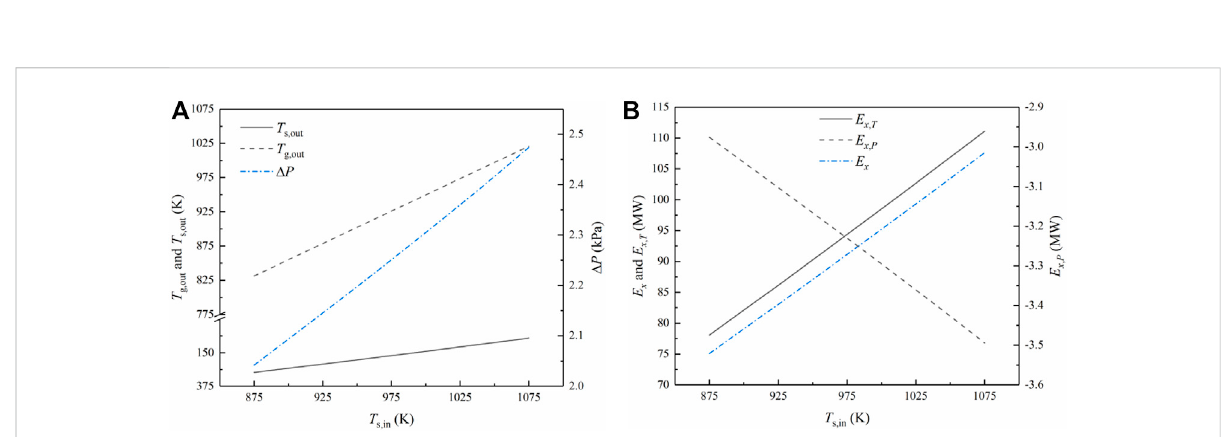
FIGURE 10 In fl uencesofthesinterinlettemperature T s , in onthecooling process: (A) Changeofthesinteroutlet temperature T s , out ,gasoutlettemperature Δ P with T T g , out and pressure drop s , in ; (B) Change of the temperature exergy